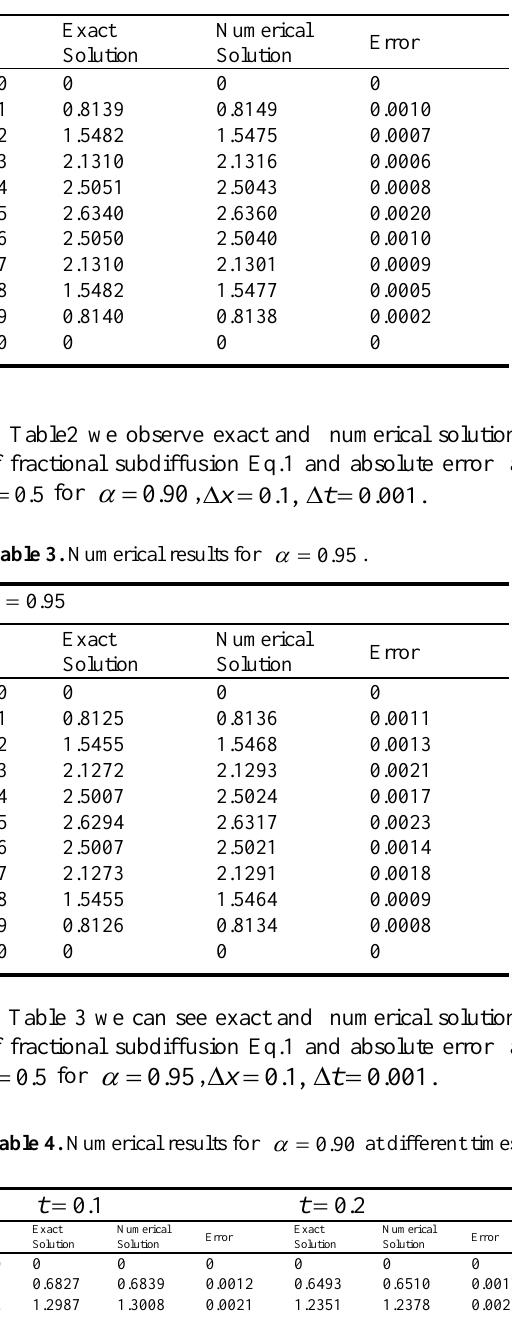
Figure 3. Numerical solution of Eq.(1) for various values of 